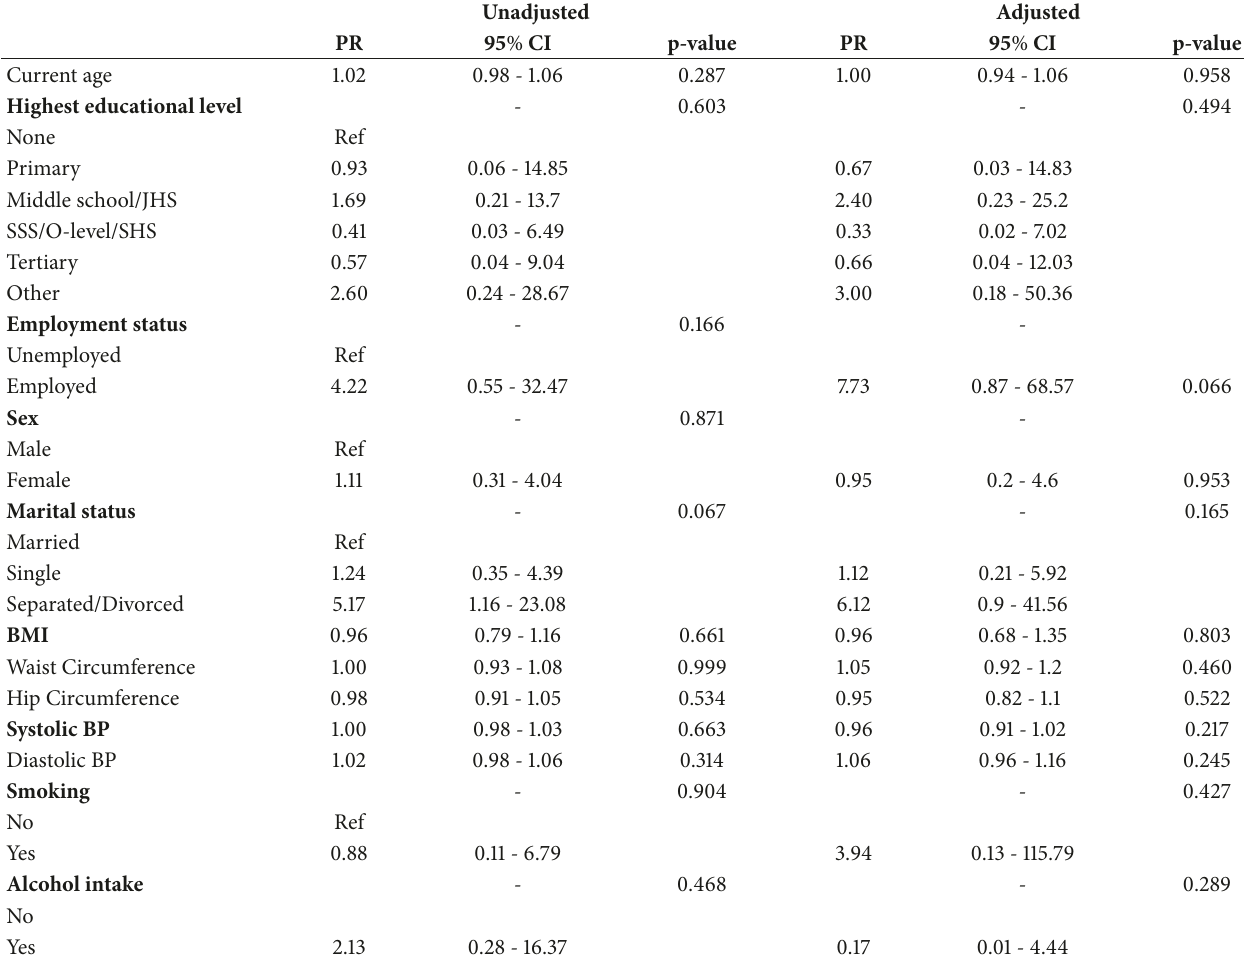
Table 6: Effects of sociodemographics factors, clinical conditions, and lifestyle factors on FPG